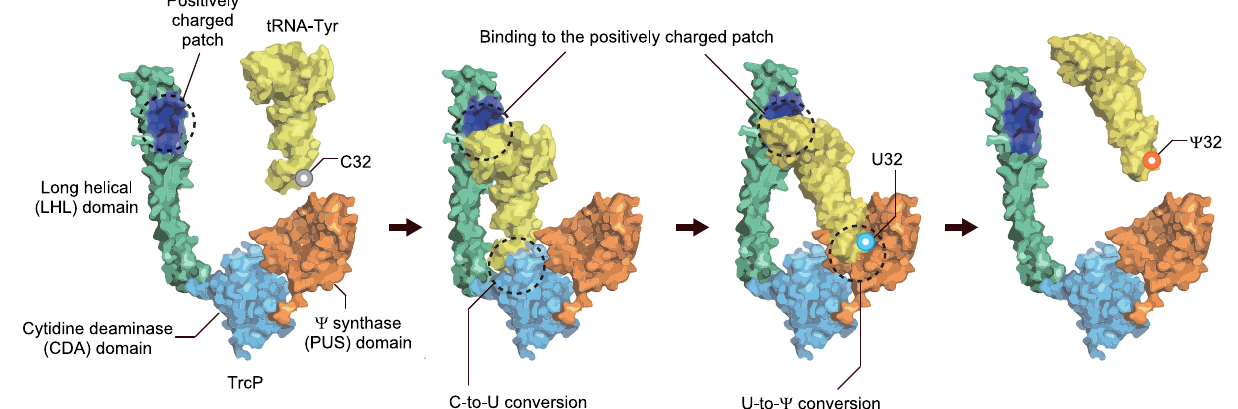
Fig. 7 | Model of TrcP mediated C-to- Ψ editing. The anticodon loop of tRNA-Tyr locatesinthecatalyticpocketoftheCDA(lightblue)domainandundergoesC-to-U conversion.ThentheanticodonmovestothePUSdomain(orange)andundergoes U-to- Ψ conversion.Duringbothreactions,the positivelycharged patch(darkblue)